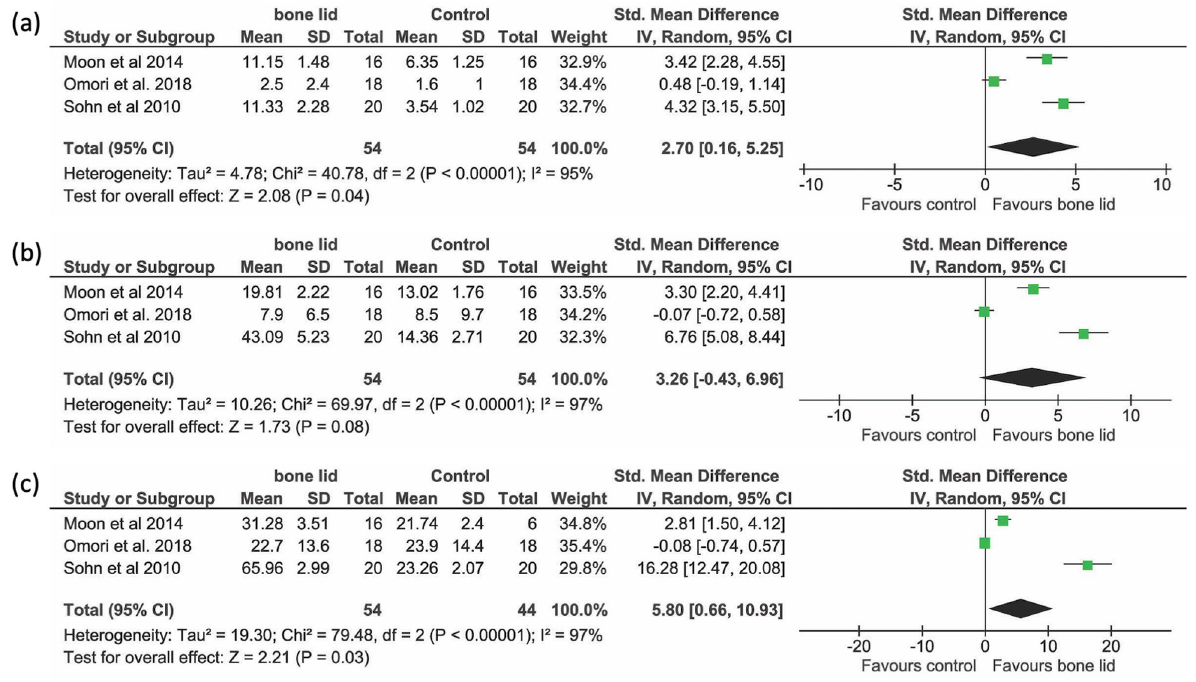
Abbreviations β-TCP: β-Tricalcium phosphate; BIC: Bone-to-implant contact; CBCT: Cone beam computed tomography; DBBM: Deproteinized bovine-derived bone mineral; RCT : Randomized clinical trial.